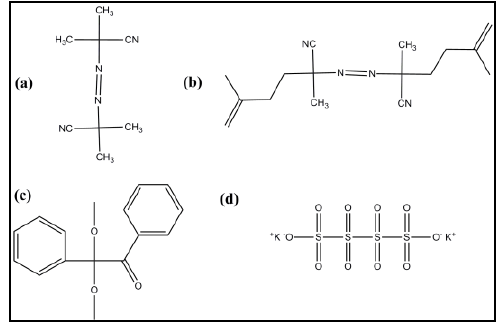
Figure 7. Common initiator structures used in MIP synthesis: ( a ) azobisisobutyronitrile (AIBN); ( b ) 4-4´-azo(4-cyanovaleric acid) (ACID); ( c ) benzoylperoxide (BPO); ( d ) potassium persulfate (KPS).